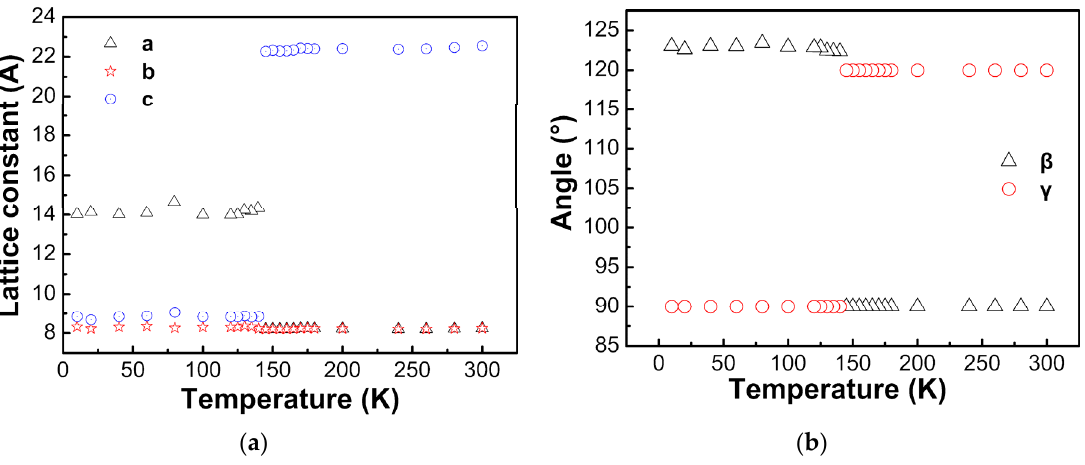
Figure 5. Temperature dependences of lattice parameters, ( a ) lattice constant, ( b ) angles. Above 145 K, Rietveld refinements of XRD patterns are consistent with rhombohe- dral R 3c with fitting parameters R wp ≤ 11.19% and R p ≤ 7.76%. Below 145 K, Rietveld refinements of XRD patterns are in agreement with monoclinic C c with fitting parameters R wp ≤ 24.22% and R p ≤ 15.97%. Jain et al. reported that due to twinning, XRD patterns